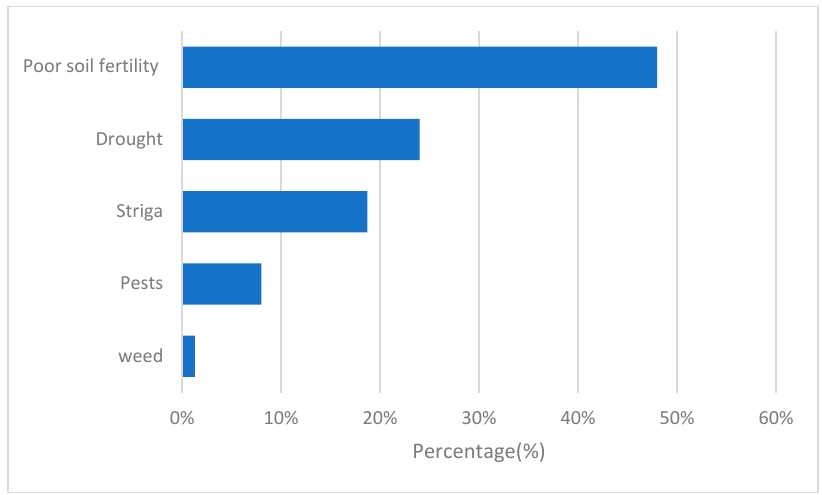
Figure 2. Pearl millet production constraints in three departments (Dogondoutchi, Dosso, and Gaya) of the Dosso region in Niger.